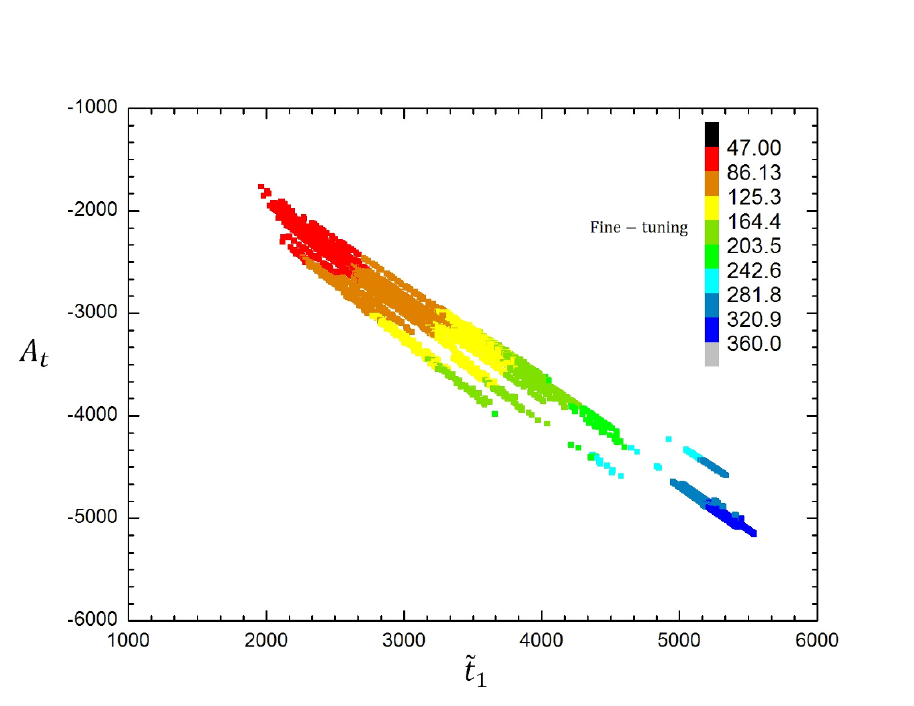
Yukawa A t and also their corresponding (cid:12)ne tuning involved. Note that the trilinear coupling A t of all points are negative.